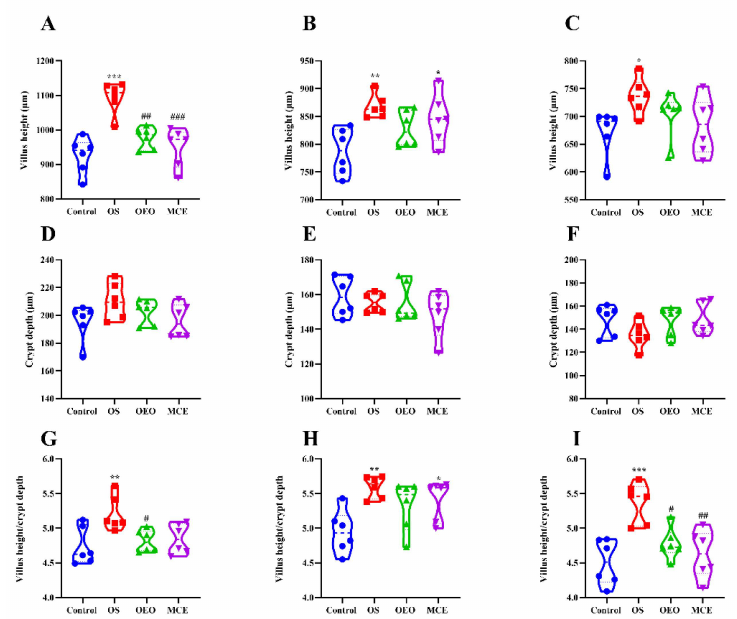
Figure 7. Intestinal wall morphology in broilers. ( A ) Duodenum of the control group. ( B ) Duodenum of the OS group. ( C ) Duodenum of the OEO group. ( D ) Duodenum of the MCE group. ( E ) Jejunum of the control group. ( F ) Jejunum of the OS group. ( G ) Jejunum of the OEO group. ( H ) Jejunum of the MCE group. ( I ) Ileum of the control group. ( J ) Ileum of the OS group. ( K ) Ileum of the OEO group. ( L ) Ileum of the MCE group. Images were obtained at 40 × magnification.